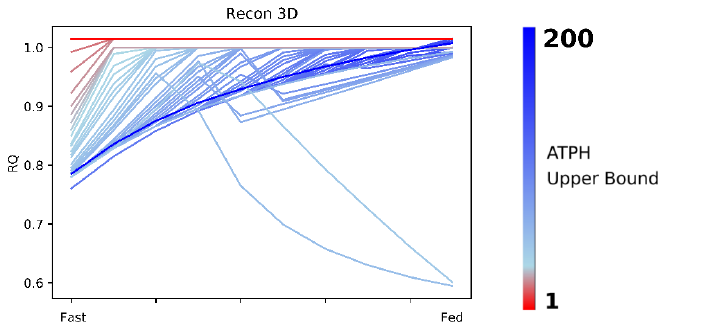
Recon2.2 and Recon3D model contain two alternative reactions for Complex IV of the electron transport chain (cytochrome oxidase), (IDs: CYOOm3i and CYOOm2i). CYOOm3i: 7.92 h m + o 2 m + 4.0 focytC m −− (cid:42)(cid:41) −− 1.96 h 2 o m + 4.0 ficytC m + 0.02 o 2 s m + 4.0 h i The two reactions have similar formulations, but CYOOm3i also produces o2s (reactive oxygen species, ROS). In model 2, o2s are converted into o2 + h2o2 by the reaction superox- ide dismutase (ID: SPODM). The o2 produced by SPODM is then reused by CYOOm3i, accounting for 1% of the input flux. This means that the o2 influx from the external com- partment into the cytosol (which is measured to compute RQ) will be 1% smaller, causing an increase in the RQ value. When the CYOOm3i reaction was deactivated in Recon3D, the model predictions returned to the expected range. In Recon2.2 the two reactions are associated with different genes. During the construction of the skeletal muscle models, which are based on Recon2.2., only one of the two reactions (CYOOm3i) was inherited by the “child” models